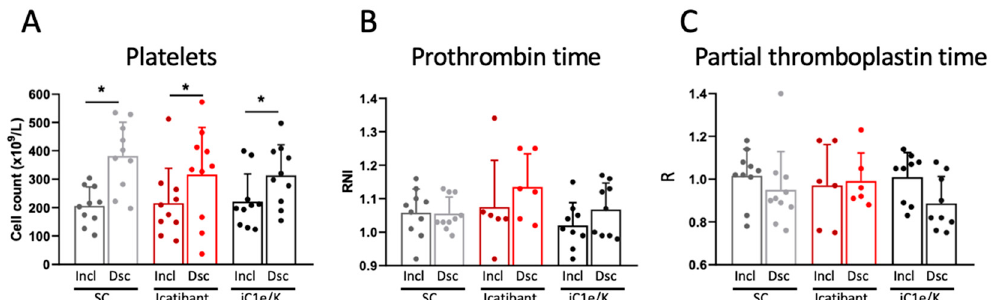
Figure 4. Coagulation-related parameters. Blood platelet counts ( A ), prothrombin time ( B ), and partial thromboplastin time ( C ) were determined in blood samples collected at inclusion and discharge. Dsc, discharge; iC1e/K, inhibitor of C1 esterase/kallikrein; Incl, inclusion; SC, standard care. Non-parametric Wilcoxon test was used for comparisons between pre- and post-intervention. Results are presented as mean ± standard deviation. * p < 0.05.